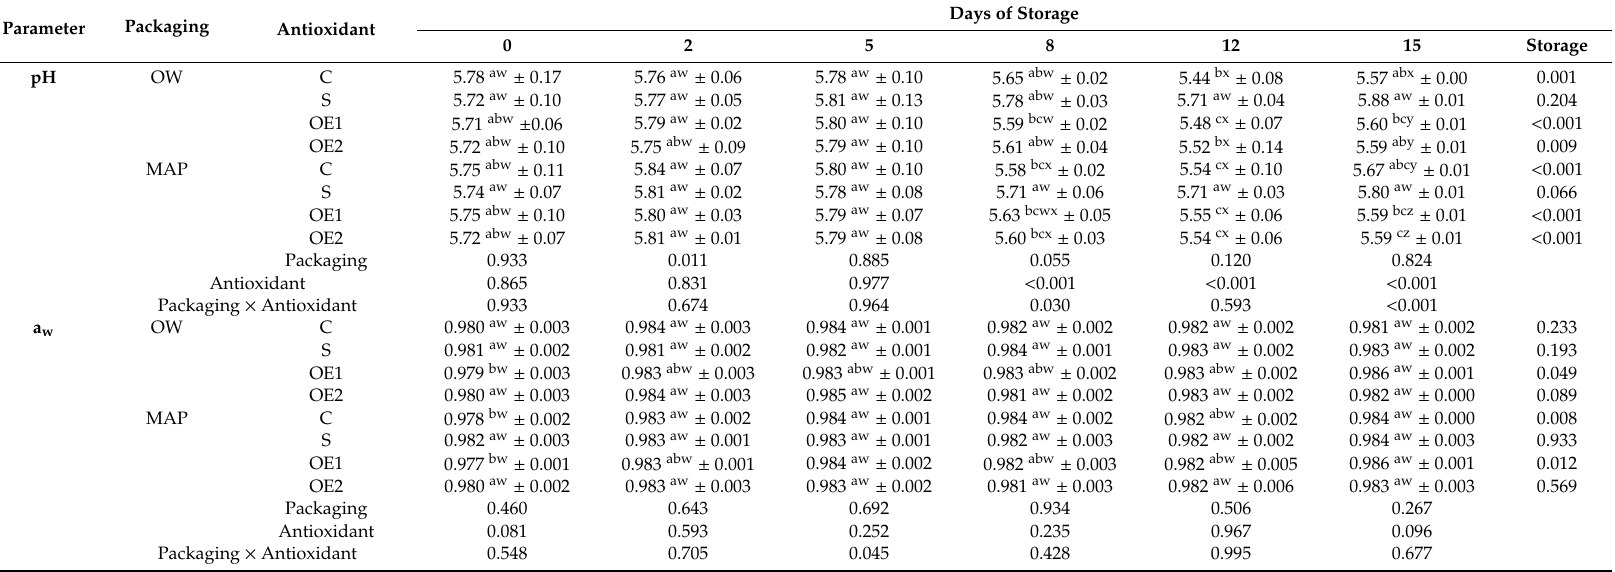
Table 2. Evolution of a w and pH (mean values ± standard deviations) of beef patties with di ff erent formulations α packed under di ff erent conditions β during 15 days of storage at 4 ◦